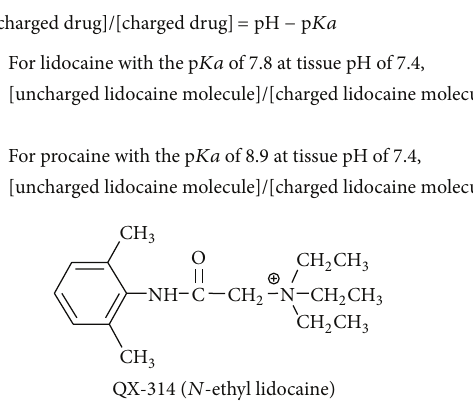
Figure 2: Uncharged and charged local anesthetics and permanently charged derivative.